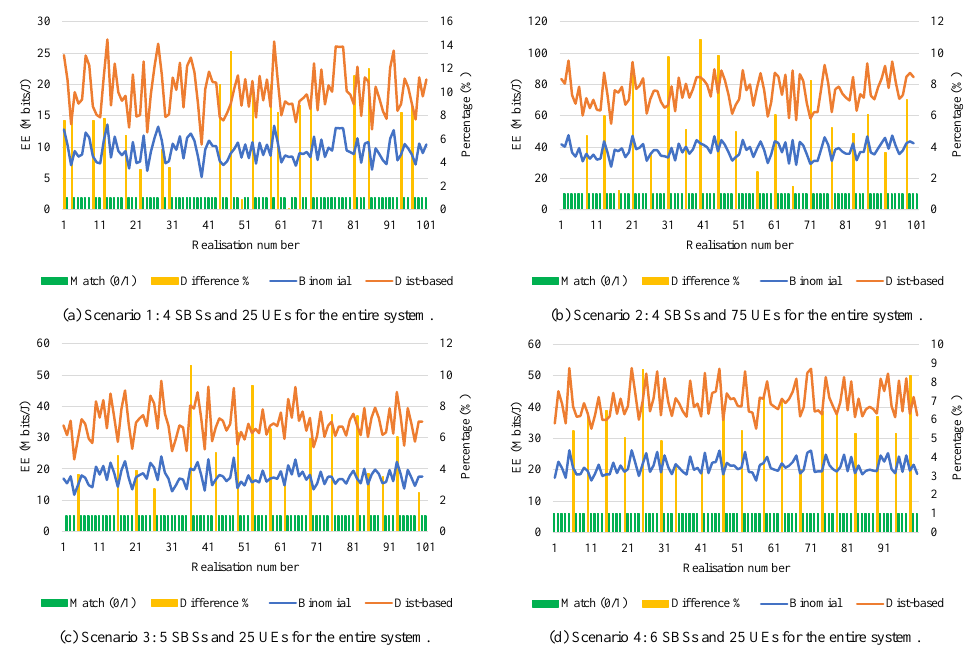
Figure 4. EE observation of 100 realisations to compare between binomial and distance-based BS-Sw techniques for different